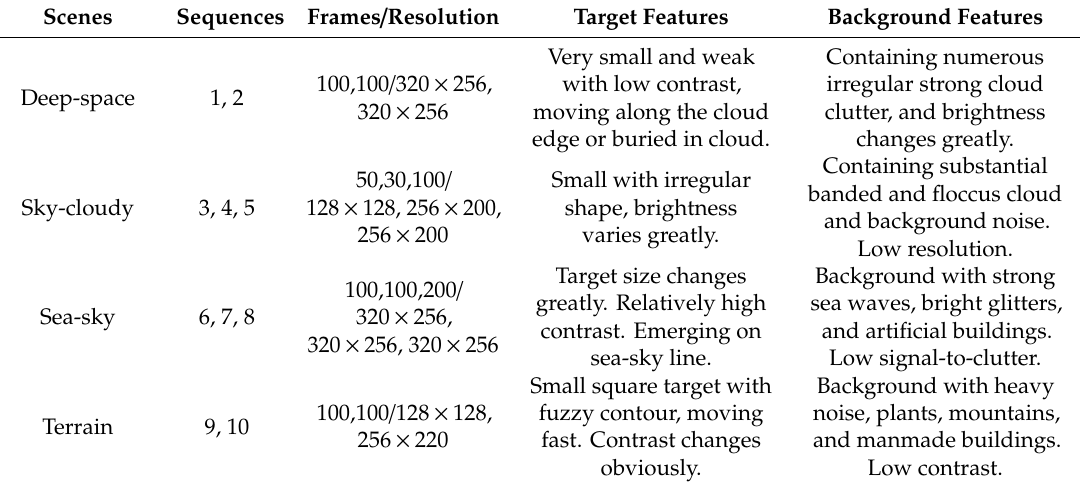
Figure 4. Exhibition of representative single image from each experimental sequence. The local area of dim target is enlarged for better observation. ( a – j ) represent Sequences 1 to 10. Table 2. Detailed information of these real sequences.